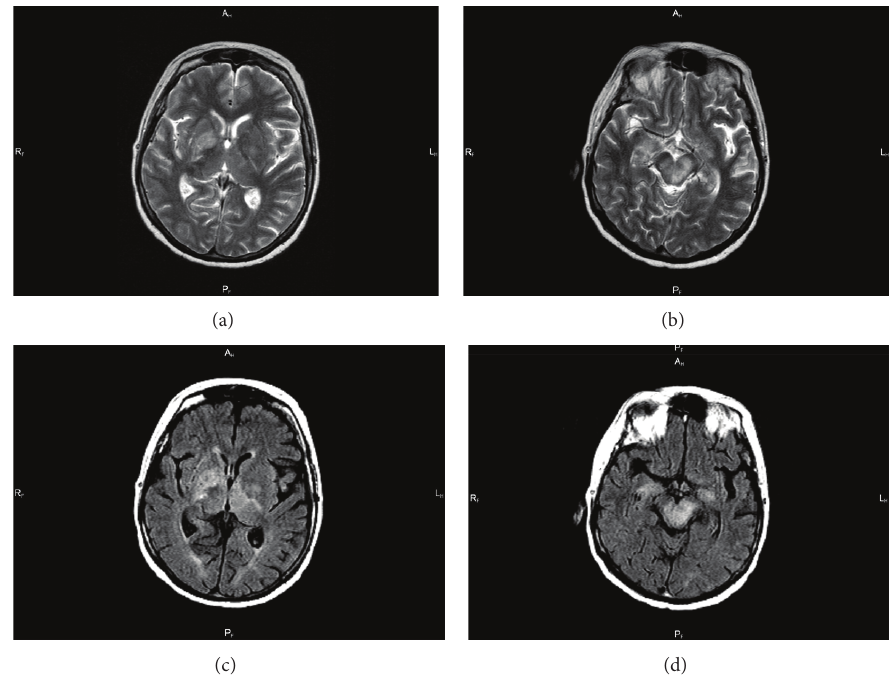
Figure 1: Brain MRI in T2 (a, b) and FLAIR (c,